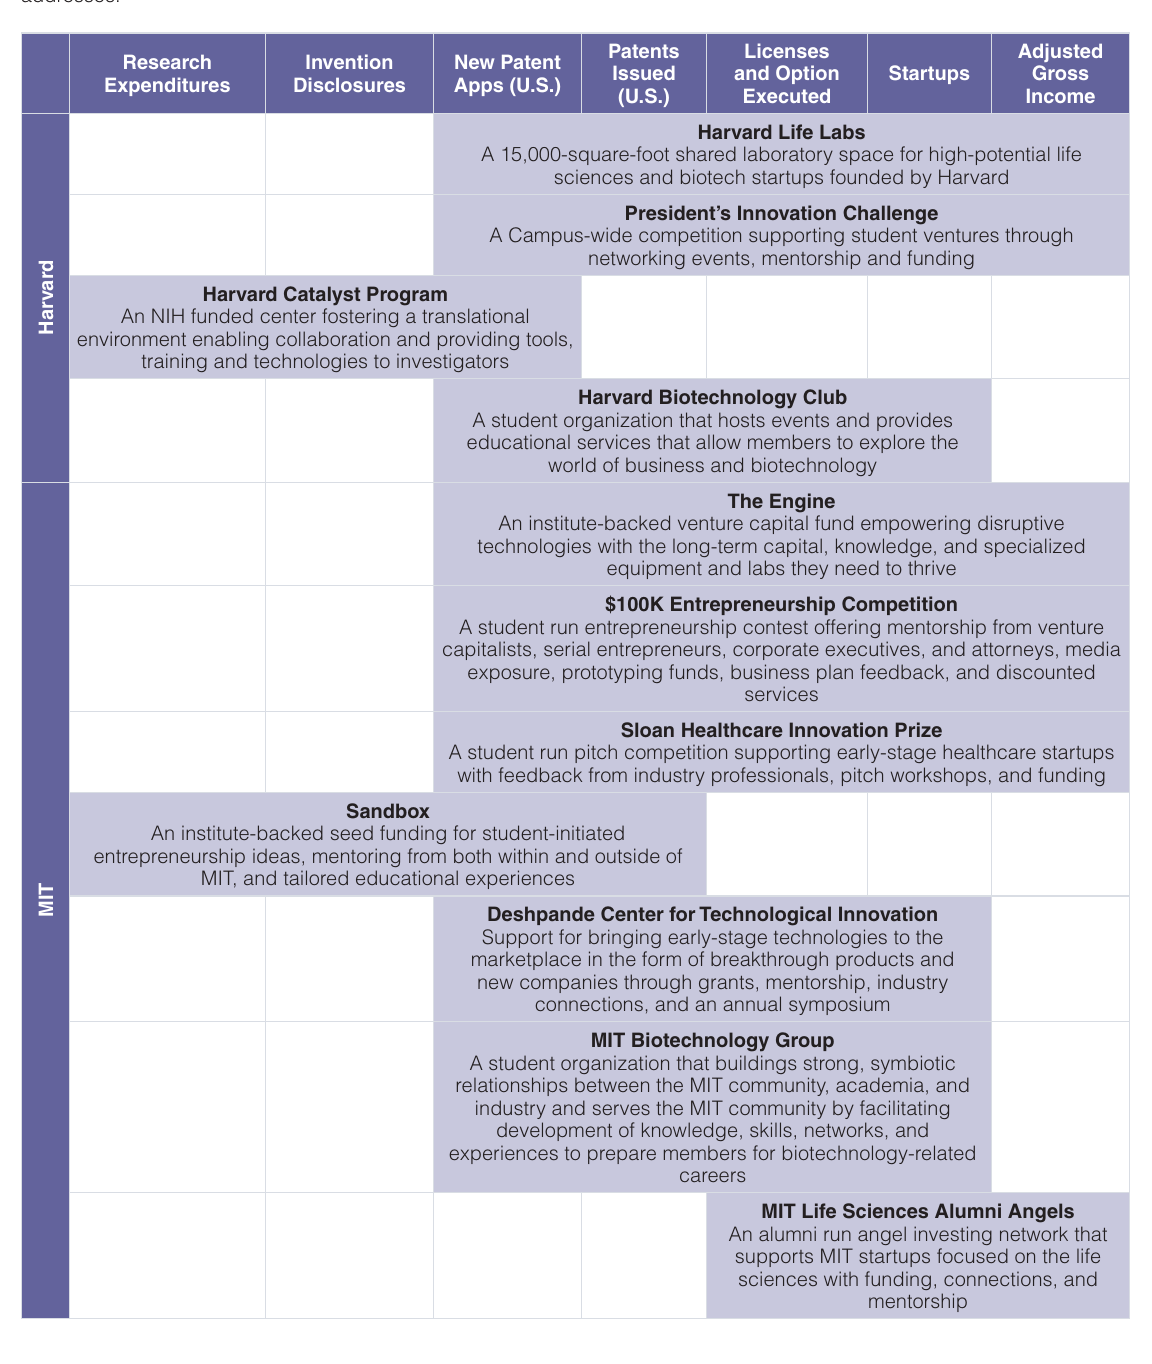
Table 2. Current programs at MIT and Harvard, two of the top-performing institutions, that strengthen the commercialization pipeline. The shaded regions denote which areas of the pipeline each program most directly